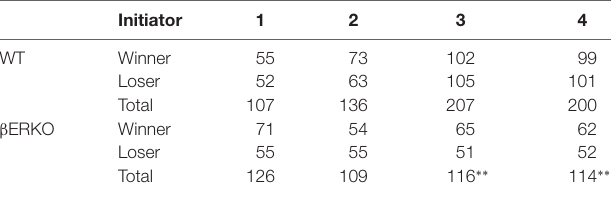
TABLE 2 | Total numbers of dyad transitions in each trial and genotype